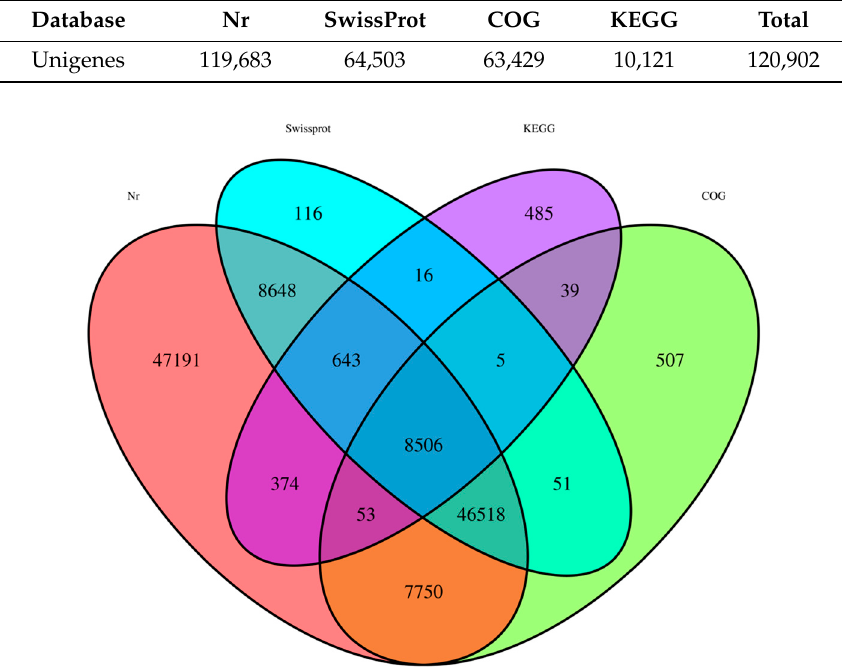
Table 1. Statistics of annotation results.